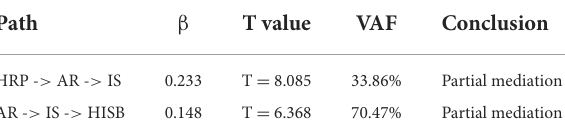
TABLE 8 The mediating effects of affective response and information sufficiency.